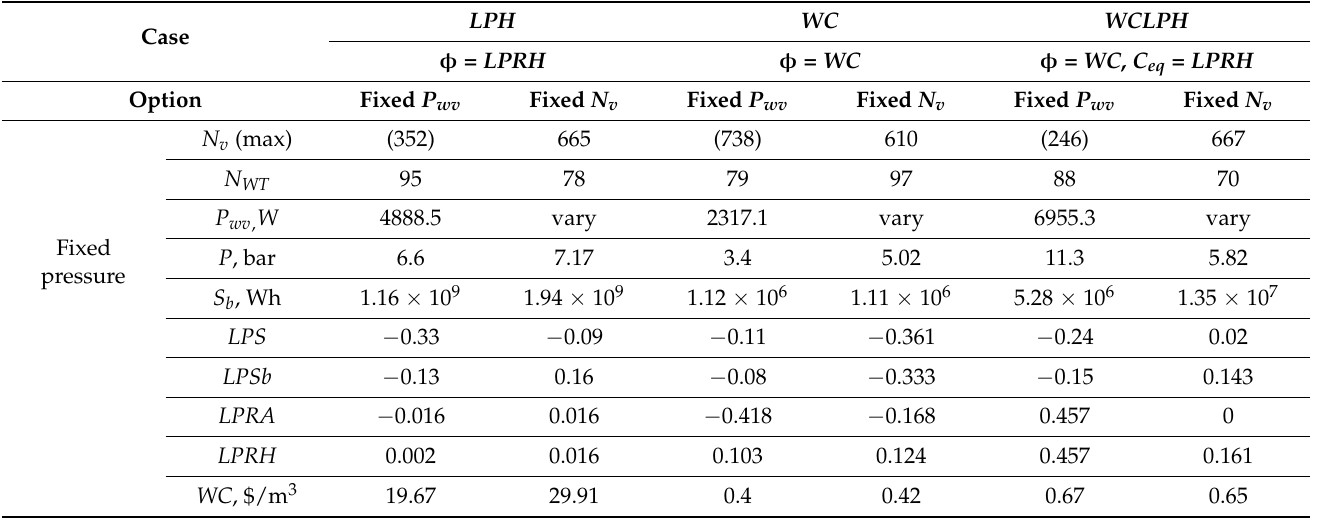
Table 3. Optimization results for satisfying the hourly production; WC : water cost, LPRH : hourly loss of power probability.